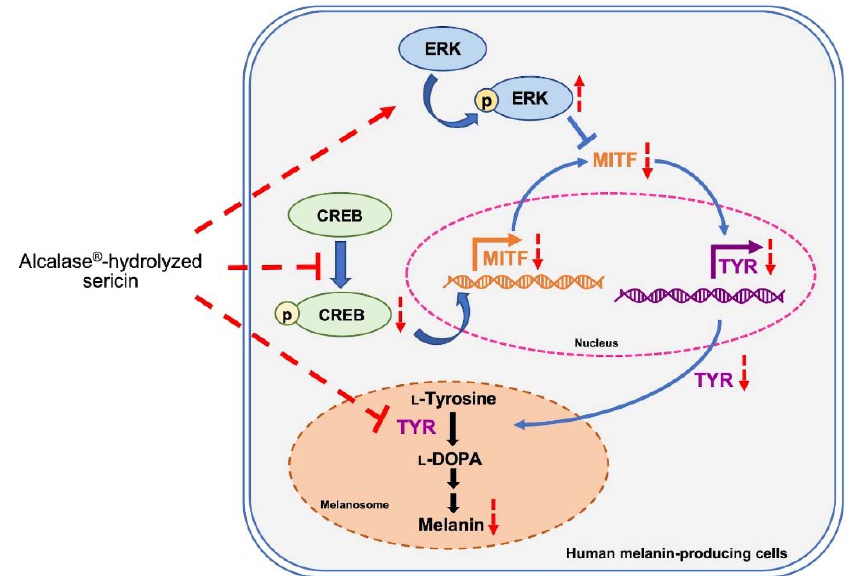
Figure 7. Alcalase ® -hydrolyzed sericin suppress melanogenesis in human melanin-producing cells through modulating MITF expression as indicated with downregulated pCREB and overexpression of pERK. Not only the reduction of tyrosinase (TYR) protein level associated with the moderated MITF level, but sericin hydrolysates modified by Alcalase ® also directly inhibit the enzymatic function of human tyrosinase consequence with lowered melanin content. The red arrows and red symbols indicate the effect of sericin hydrolysates in human melanin-producing cells.